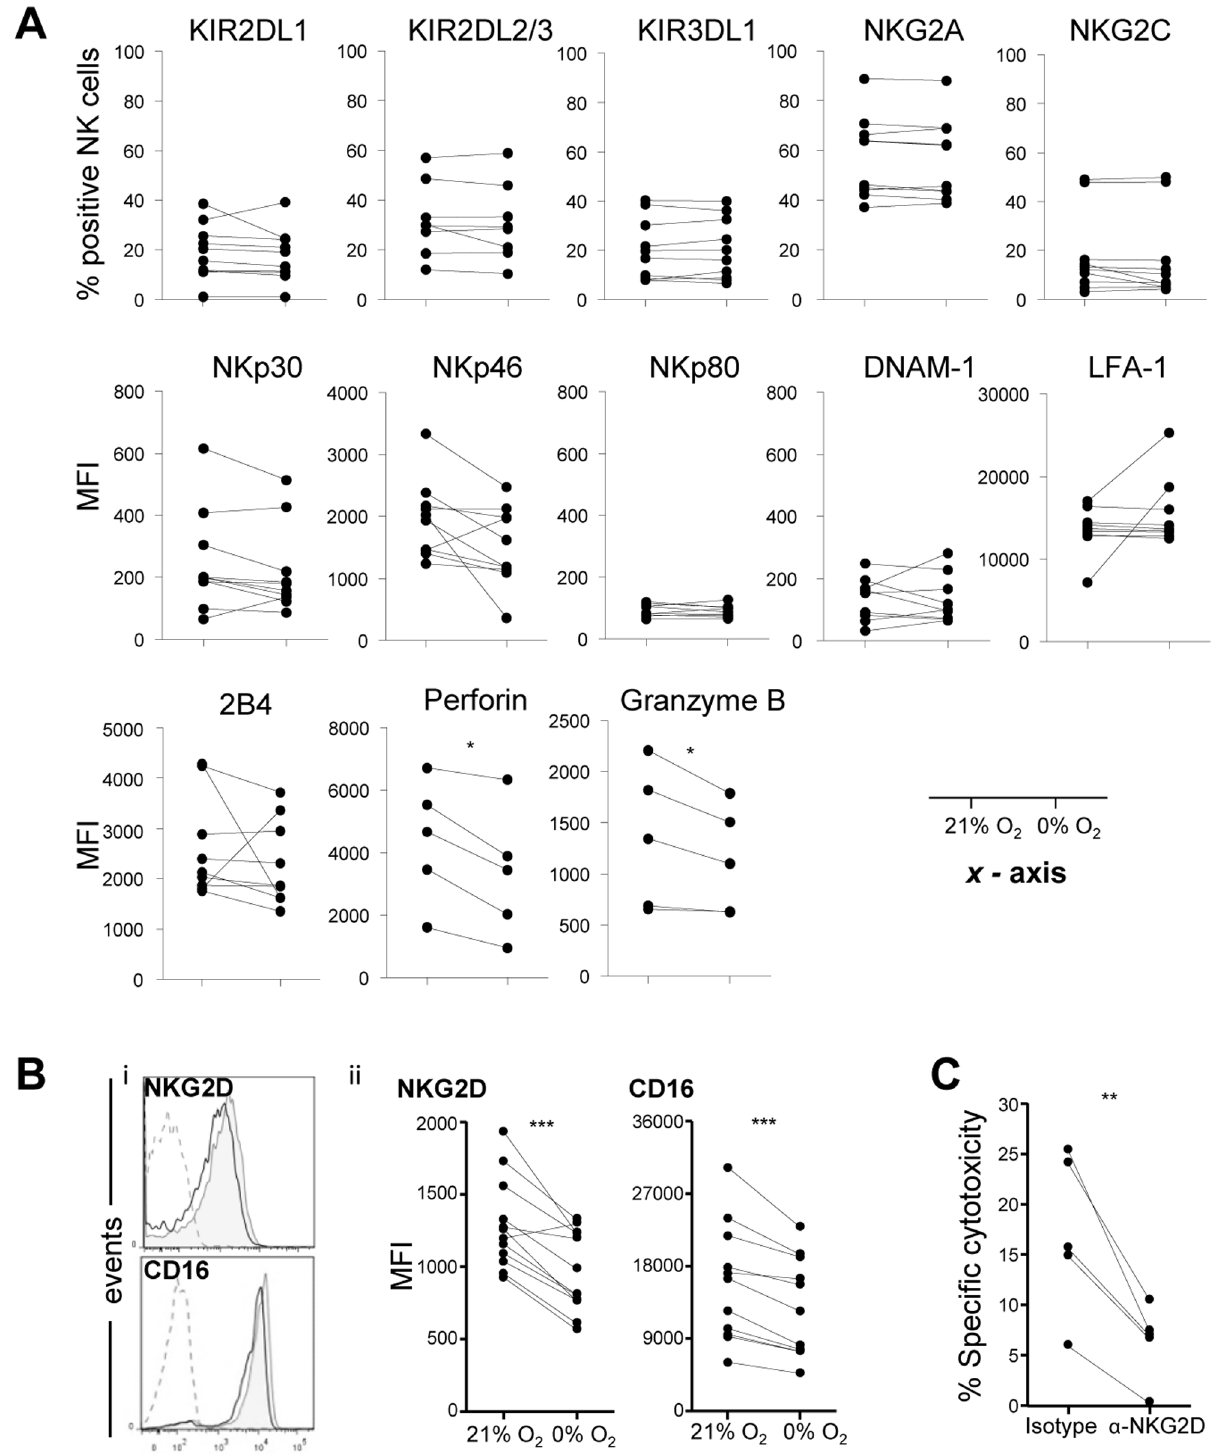
Figure 2. Hypoxia reduces surface expression of NKG2D and CD16 on NK cells and intracellular perforin and granzyme B. (A) Flow cytometric analysis of surface expression of NK cell receptors and intracellular perforin and granzyme B after 14–16 hours of incubation at 21% or 0% O 2 . Graphs depict quantification of the % positive NK cells or MFI for the different receptors. Each dot represents one donor. Shown alongside the graphs is the x -axis oxygen parameter for the graphs. (B) Flow cytometric analysis of surface expression of NKG2D (n=12) and CD16 (n=11) on NK cells after 14–16 hours of incubation at 21% or 0% O 2 . (i) Representative histograms of surface expression at 21% O 2 (grey filled) or 0% O 2 (solid black line) and matched isotype control (dashed line) are displayed. (ii) Graphs represent quantification of the independent donors. (C) Cytotoxicity assay at E:T 20:1 in the presence of 10 m g/ml a -NKG2D blocking antibody or matched isotype control. Each dot represents an individual donor. Statistics were performed with paired t - test. ** p , 0.01 and *** p , 0.001. doi:10.1371/journal.pone.0064835.g002 PLOS ONE |